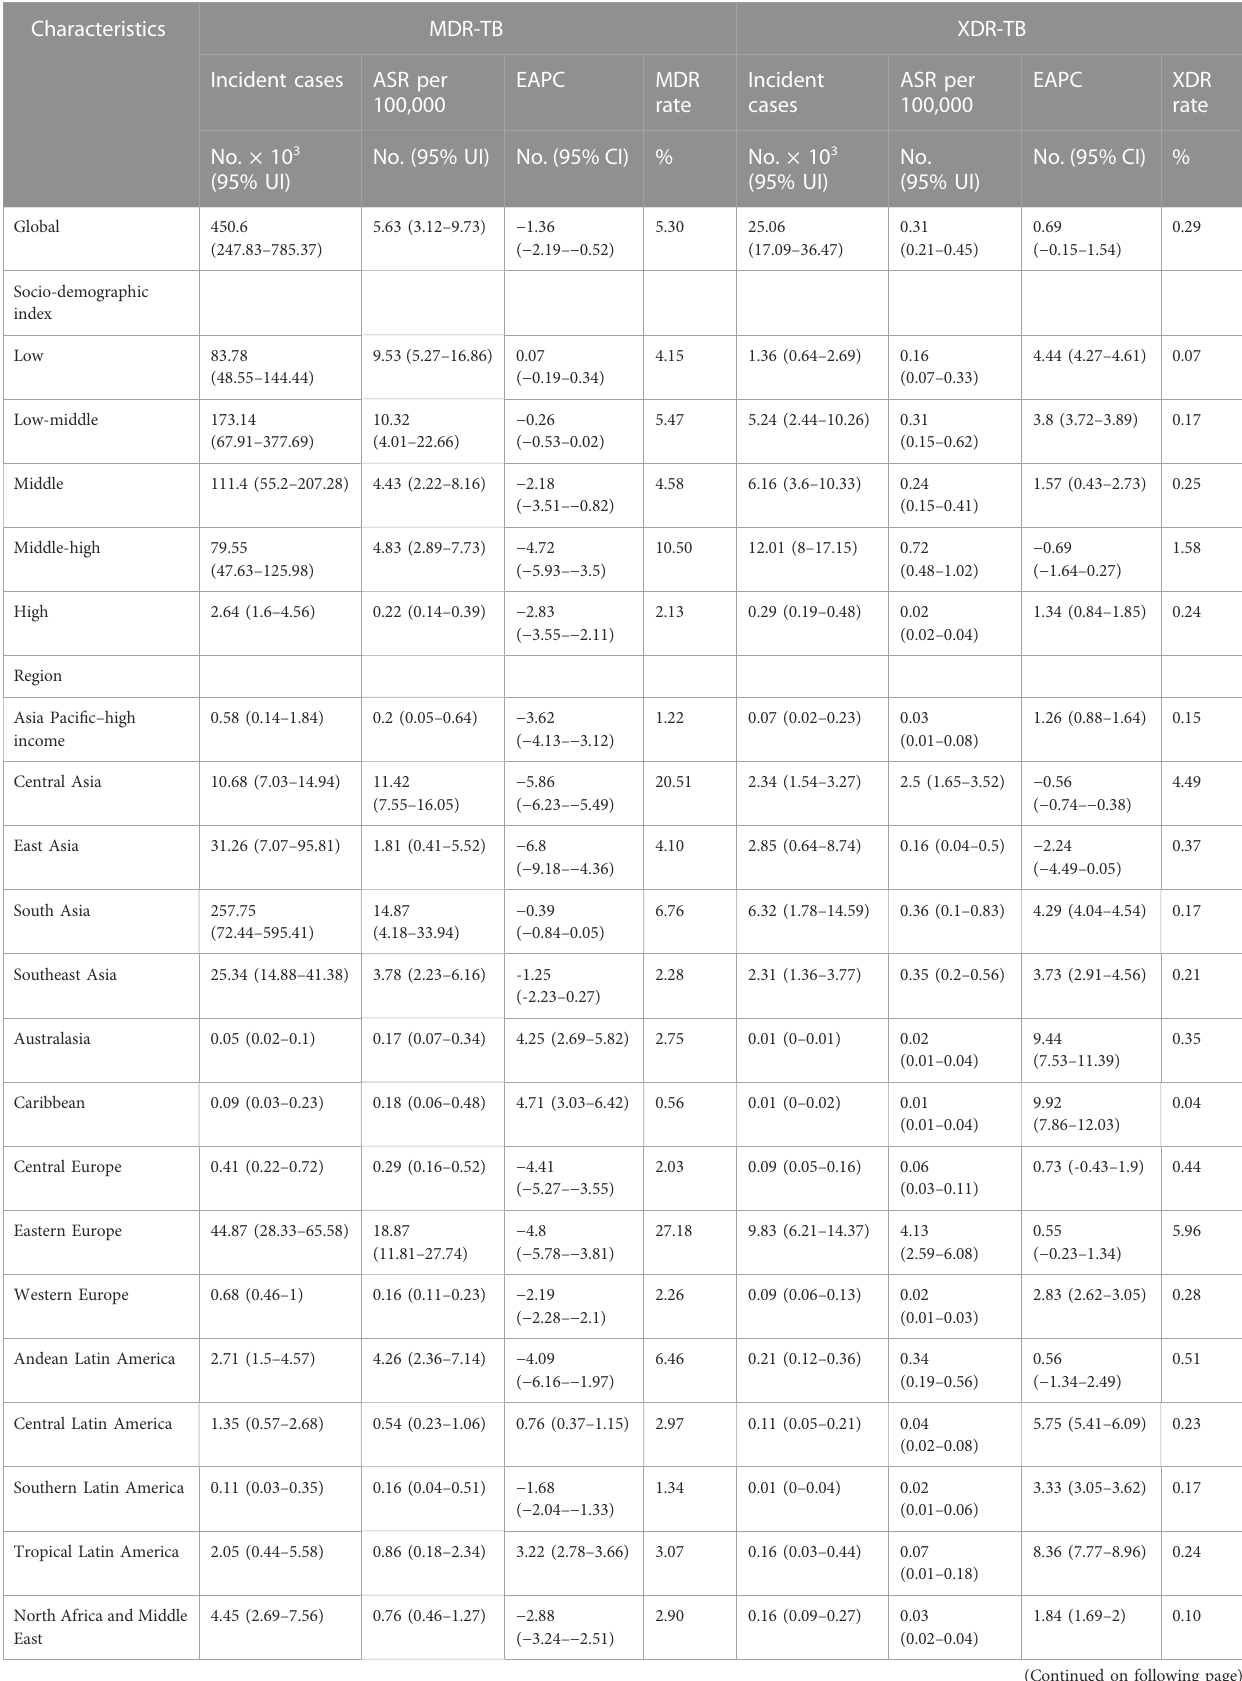
TABLE 1 The cases and ASR for incidence of MDR-TB and XDR-TB in 2019, their temporal incident trends from 2010 to 2019, and MDR and XDR rate of TB.